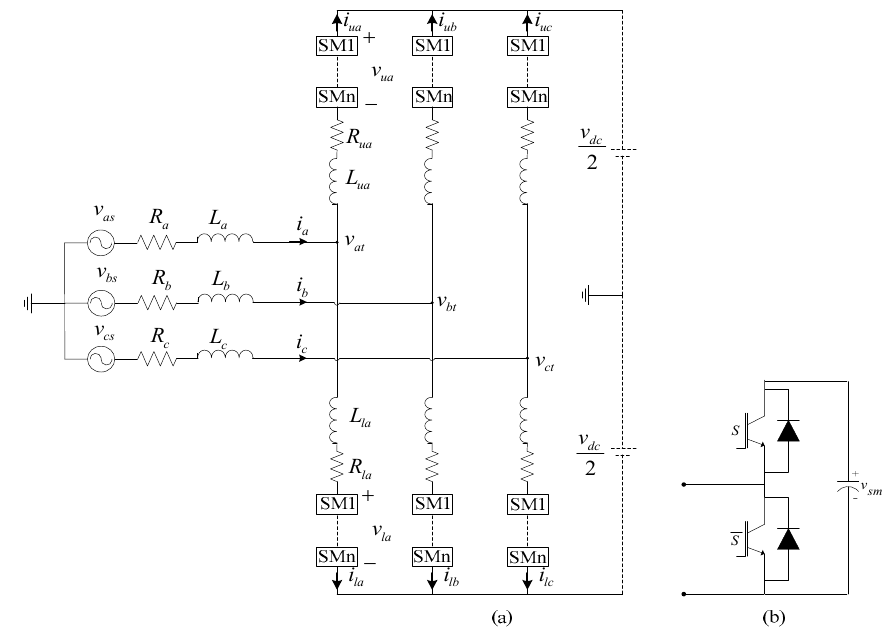
Figure 1. ( a ) The proposed three ‐ phase modular multilevel converter (MMC) based model; and ( b ) sub ‐ module (SM).